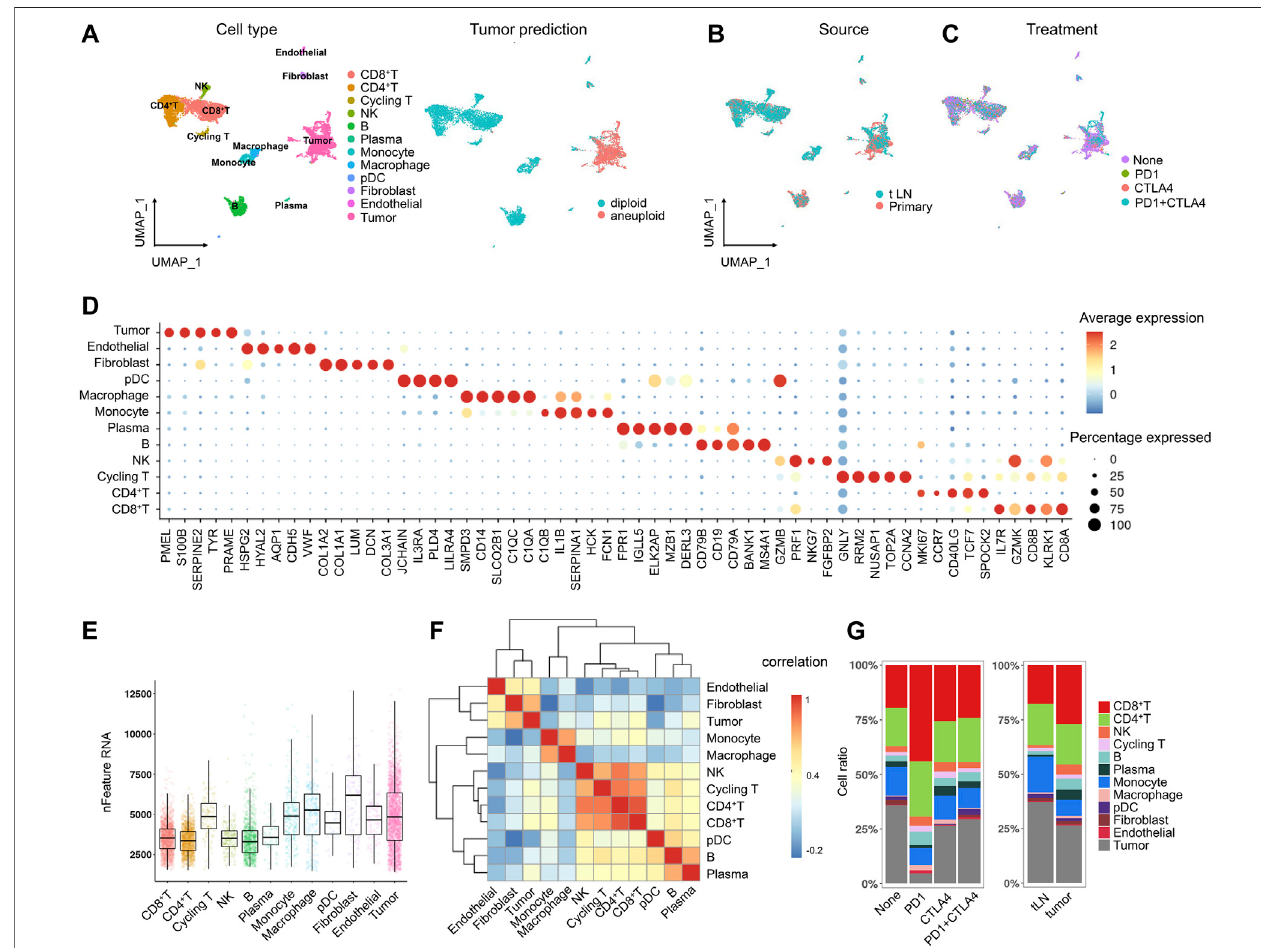
FIGURE1| Single-cellatlasofthemelanomatissue. (A) UMAPprojectionofthelandscapeofmelanoma;12mainclusterswereidenti fi edbytranscriptomepro fi ling across7,186cellsafterquality control,dimensionalityreduction,andclustering.TumorcellswerepredictedbyCopyKAT (B,C) .UMAPprojectionoftheclusterscolored by sample source (B) and treatment (C) . (D) Dot plot displaying the fractions of expressing cells (dot size) and mean expression level in expressing cells (dot color) of marker genes (rows) across clusters (E) . Boxplot of the number of detected genes in clusters in melanoma (F) . Heatmap of the lineage correlations between melanoma T-cell clusters (CD4 + T, CD8 + T, NK, and T-prolif), B-cell clusters [ (B) , plasma], and stromal clusters (endothelial cells and fi broblasts) were clustered (G) . Bar plots of the cellular sources for 12 clusters in different sample and treatment groups.